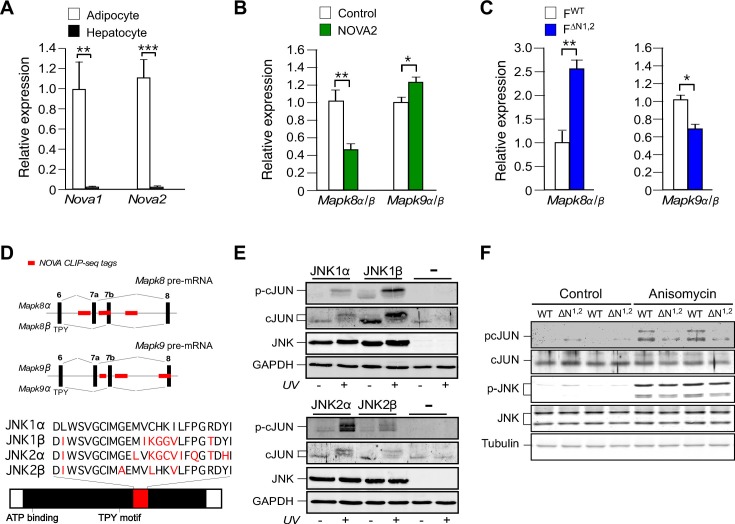
NOVA promotes signal transduction by JNK in adipose tissue.(A) The expression of Nova mRNA in adipocytes and hepatocytes was measured by quantitative RT-PCR (mean ± SEM; n=7~8; **p<0.01; ***p<0.001). The source data are included as Figure 3—source data 1. (B) The α / β expression ratios of Mapk8 and Mapk9 mRNA by hepatocytes was measured by quantitative RT-PCR (mean ± SEM; n=10; *p<0.05; **p<0.01). The effect of hepatic expression of GFP (Control) or NOVA2 using adenoviral vectors was examined. The source data are included as Figure 3—source data 2. (C) The expression ratio of the α and β isoforms of Mapk8 and Mapk9 mRNA by FWT and F∆N1,2 adipocytes was measured by quantitative RT-PCR (mean ± SEM; n=5~8; *p<0.05; **p<0.01). The source data are included as Figure 3—source data 3. (D) The mutually exclusive inclusion of exons 7a or 7b in Mapk8 and Mapk9 mRNA is illustrated. NOVA CLIP-seq tags are highlighted in red. (E) Mapk8∆/∆ Mapk9-/- MEF transduced with retroviruses expressing JNK1α, JNK1β, JNK2α, JNK2β or empty vector (-) were exposed without and with 60 J/m2 UV (60 min) and lysates were examined by immunoblot analysis. (F) Adipocytes prepared from FWT and F∆N1,2 mice were treated without and with 1 µg/ml anisomycin (10 min) and lysates were examined by immunoblot analysis.DOI:
http://dx.doi.org/10.7554/eLife.17672.01410.7554/eLife.17672.015Figure 3—source data 1.Source data for Figure 3A.DOI:
http://dx.doi.org/10.7554/eLife.17672.01510.7554/eLife.17672.016Figure 3—source data 2.Source data for Figure 3B.DOI:
http://dx.doi.org/10.7554/eLife.17672.01610.7554/eLife.17672.017Figure 3—source data 3.Source data for Figure 3C.